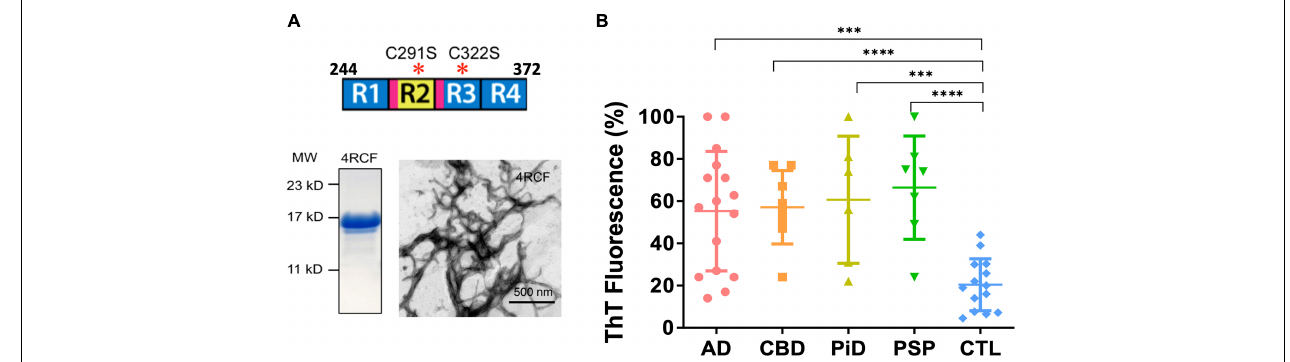
FIGURE 2 | Recombinant truncated tau protein 4RCF and scattered plot of tau-aggregation seeding activity (tau-ASA) of brain tissues from tauopathies. (A) Schematic representation of truncated tau protein (upper panel; four repeating segments of 2N4R only, with two cysteine to serine mutations – cysteine free, therefore its name 4RCF; it covers the four-repeating segment of tau by spanning the amino acid sequence from 244 to 372 of the longest isoform 2N4R tau). Locations for the hexapeptide sequences (VQIINK in R2 and VQIVYK in R3) are highlighted in magenta. SDS-PAGE of purified recombinant 4RCF and corresponding 4RCF fibrils transmission electron microscopy (TEM) image are shown in the lower panels. (B) Tau-ASA is represented by the percentage of tau ThT fluorescence at the endpoint of brain tissues after real-time quaking-induced conversion analyses (RT-QuIC) assay. Corresponding time-dependent ThT fluorescence kinetic curves are shown in Supplementary Figure 4 . The brain tissues from Alzheimer’s disease (AD) ( n = 16), CBD ( n = 8), PiD ( n = 6), PSP ( n = 7) and control (CTL, n = 14) were examined by RT-QuIC assay in the presence of the 4RCF tau substrate. AD: 55.3 ± 28.4 (average ± SD); CBD: 57.1 ± 17.5; PiD: 60.7 ± 30.1; PSP: 66.4 ± 24.5 and CTL: 21.0 ± 12.1. ∗∗∗∗ p < 0.0001; ∗∗∗ p <